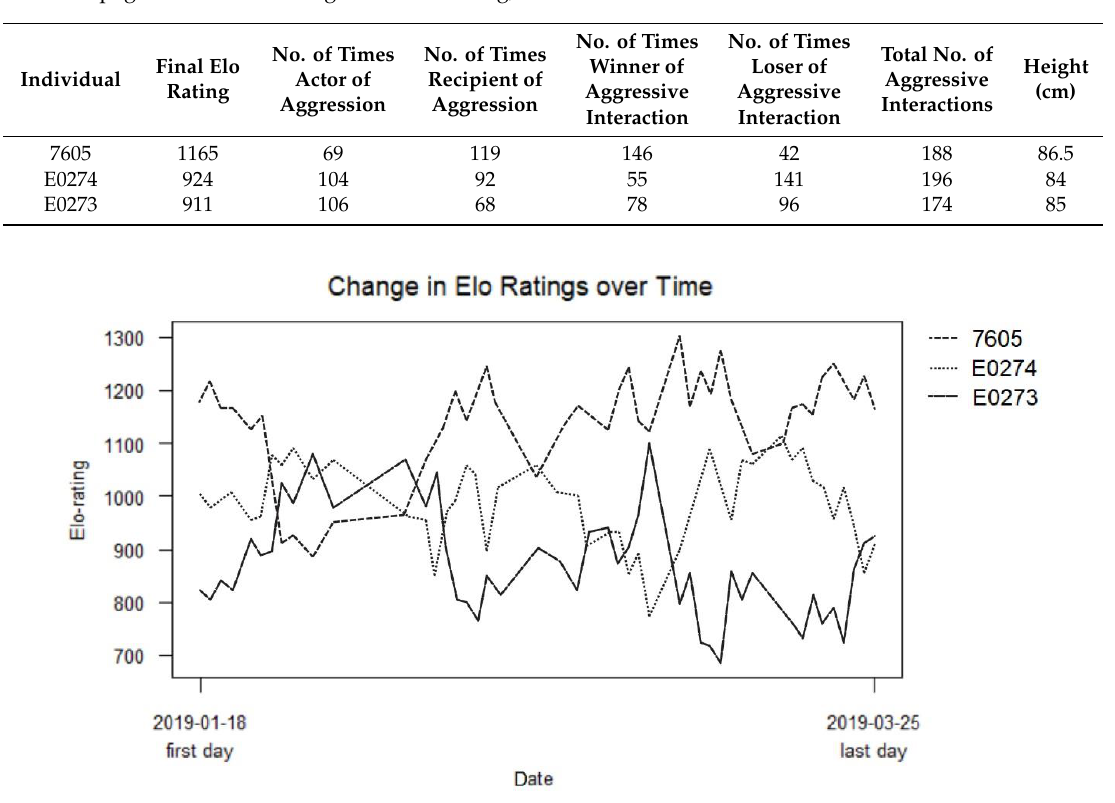
Figure 3. Elo ratings of the aggressive interactions between 7605, E0274 and E0273 over the course of the study. The first point for each line represents the rank differential that has been generated from one day of interactions.